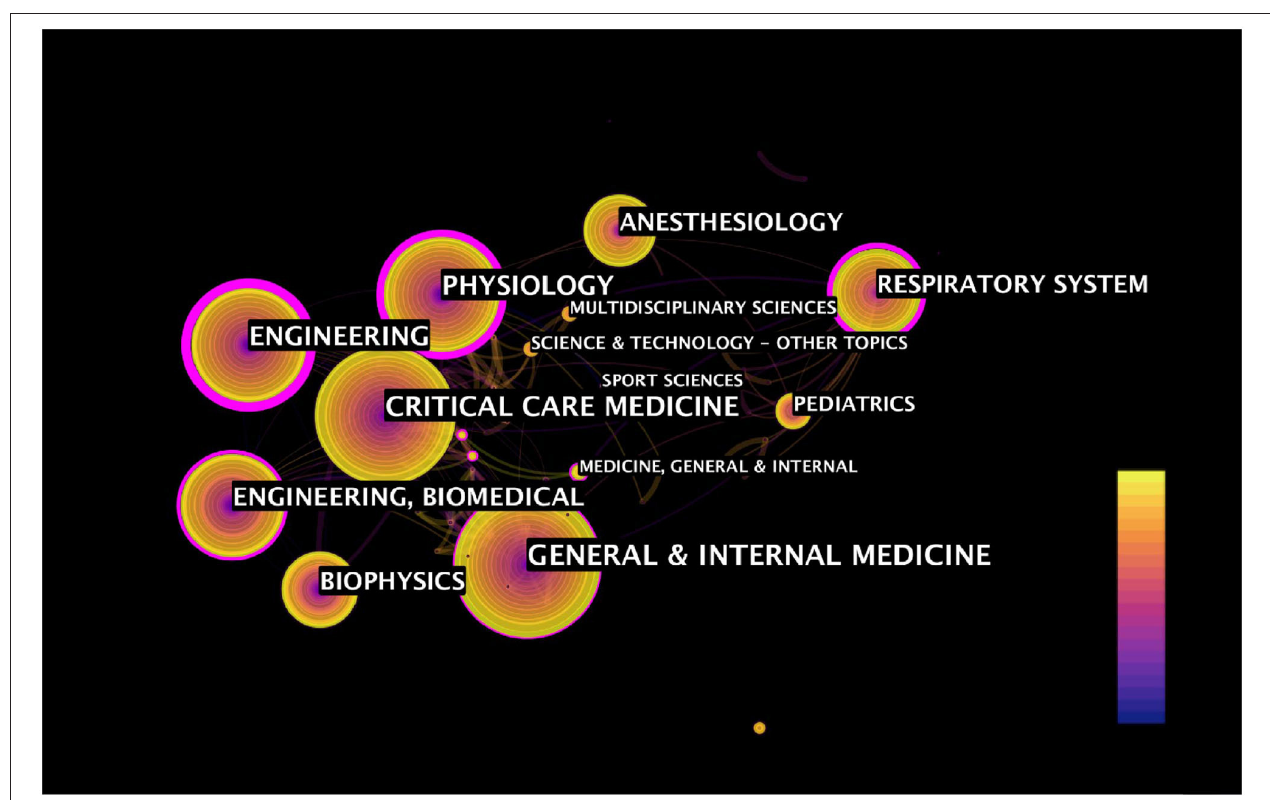
FIGURE 8 | The category co-occurrence analysis on EIT applications in clinical lung monitoring research from 2001 to May 29, 2021. The circle indicates the category; the circle size indicates publication number, the color shows the first publication year. The thickness of the lines indicated the strength of the linkage. The purple ring indicates centrality above 0.1 of categories. Centrality: metric score indicates the catenation value of the category in the entire network structure, ranges from 0–1, above 0.1 indicate turning